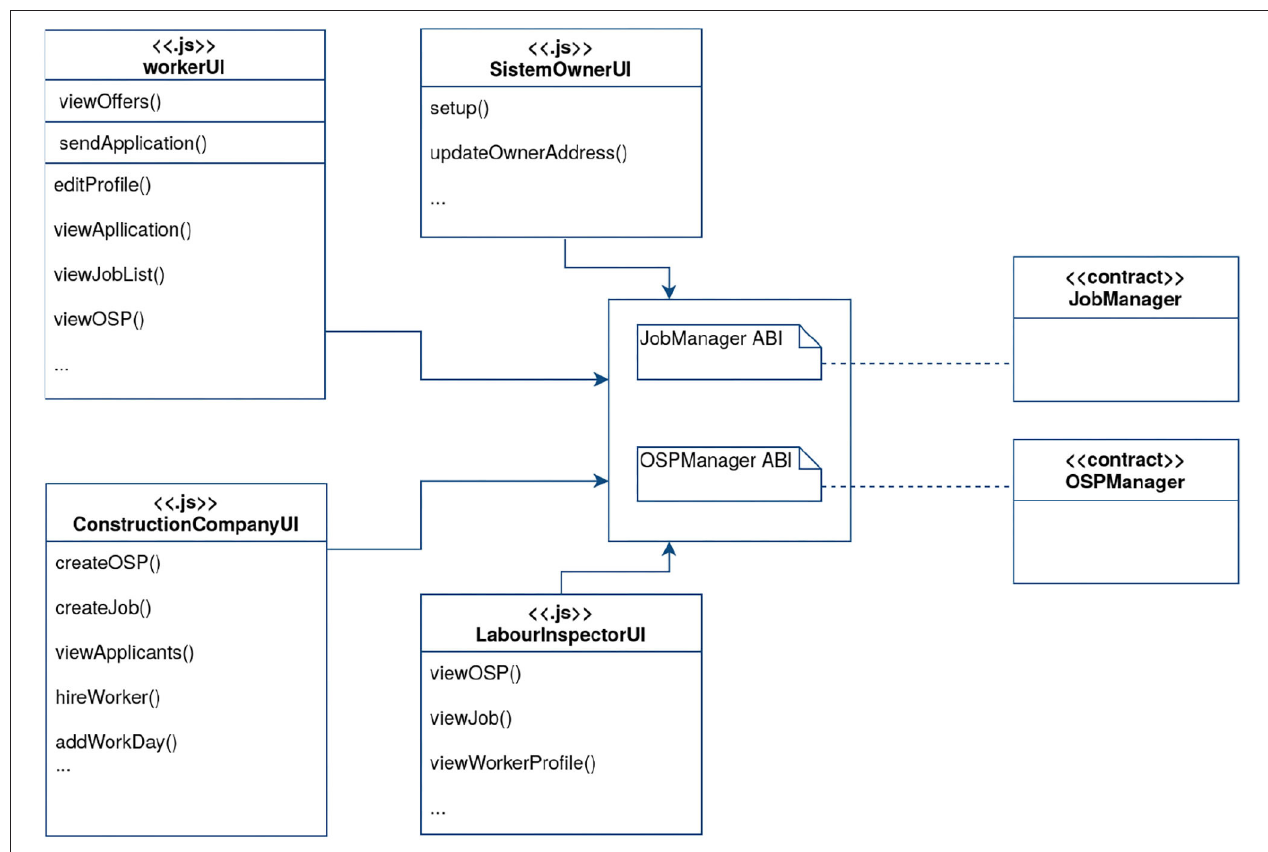
FIGURE 9 | Block diagram of the elements of the web-based user interfaces. The stereotype .js represents the javascript modules that implement the user interface. The four .js modules share the couple of ABI files, which they need to interact with the on-chain component of the